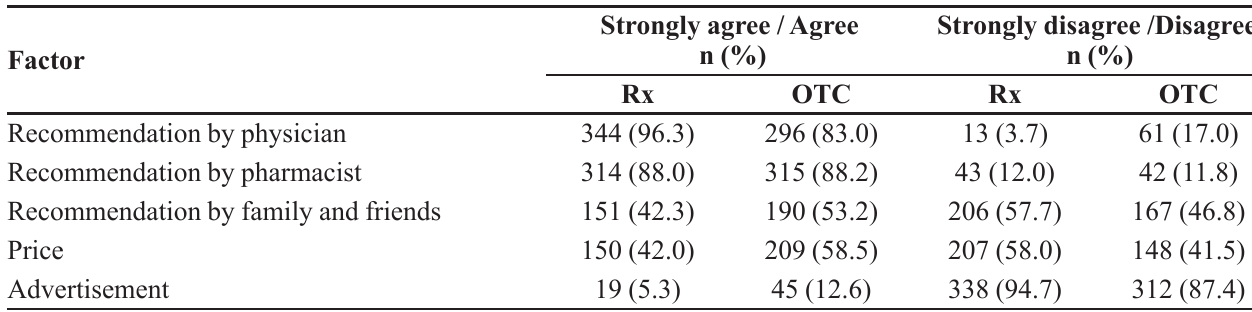
TABLE V - Participant’s expectations towards pharmacists during purchase of medicines (%; n = 357)